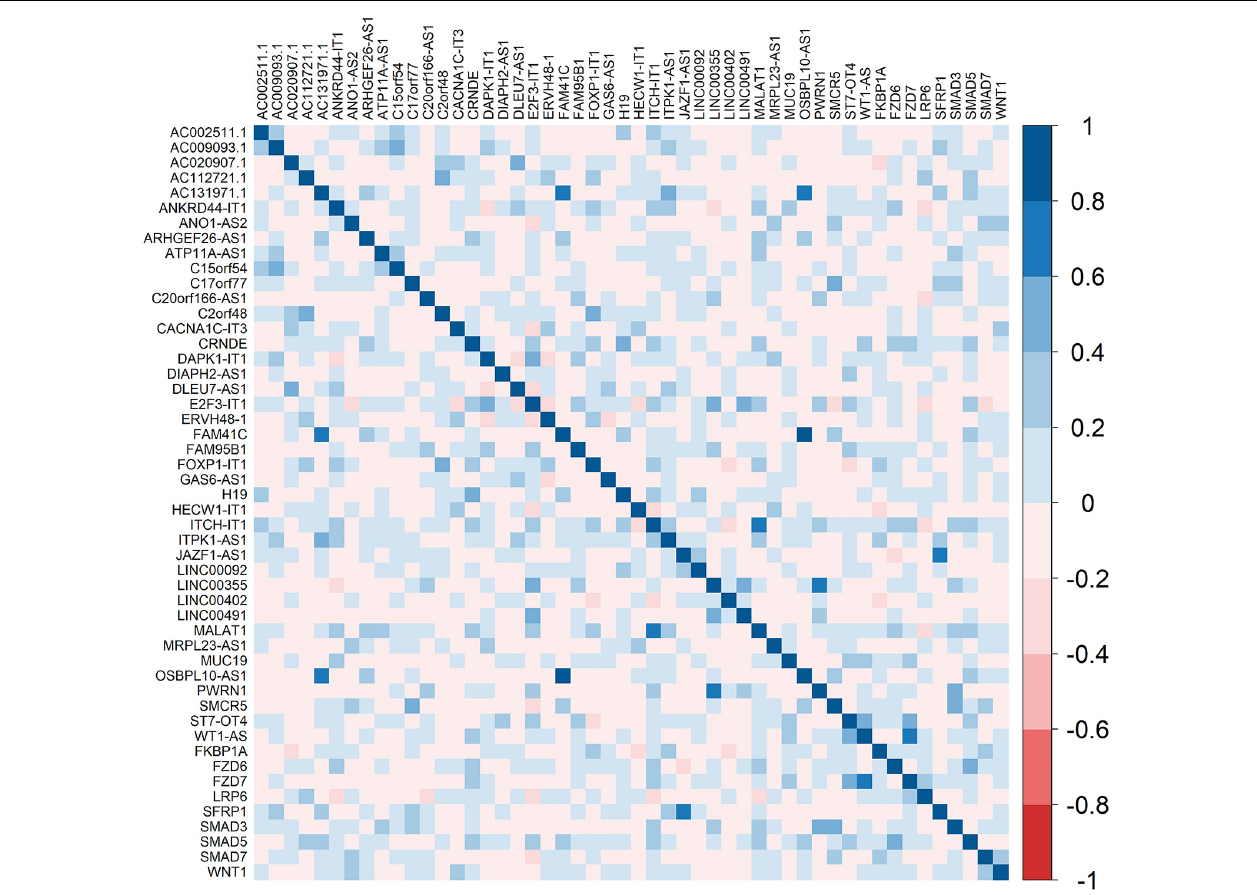
FIGURE 9 | Heatmaps showing the correlation between hub genes and DElncRNAs. DEmRNAs: Differentially expressed mRNAs. The right bar indicates the color legend of Pearson correlation values.